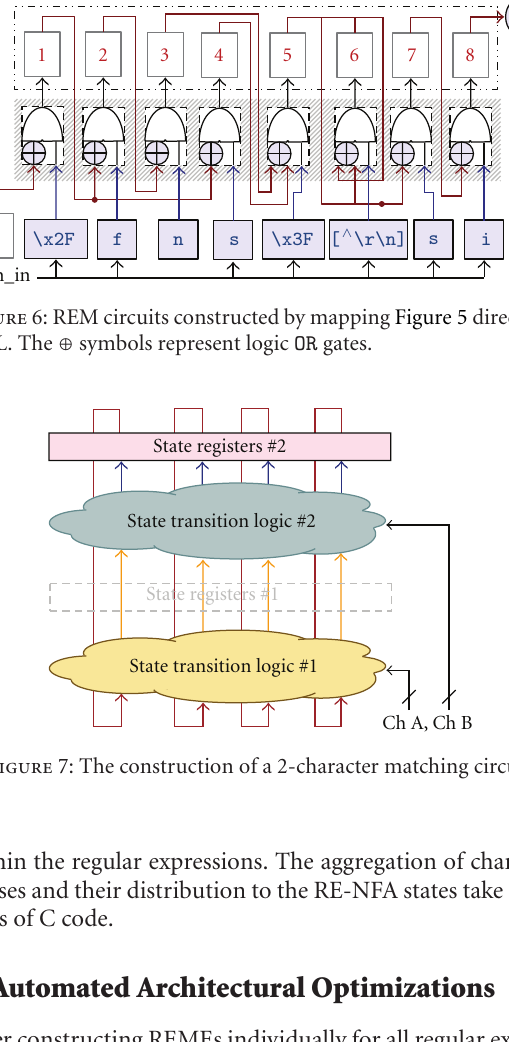
within the regular expressions. The aggregation of character classes and their distribution to the RE-NFA states take ∼ 250 lines of C